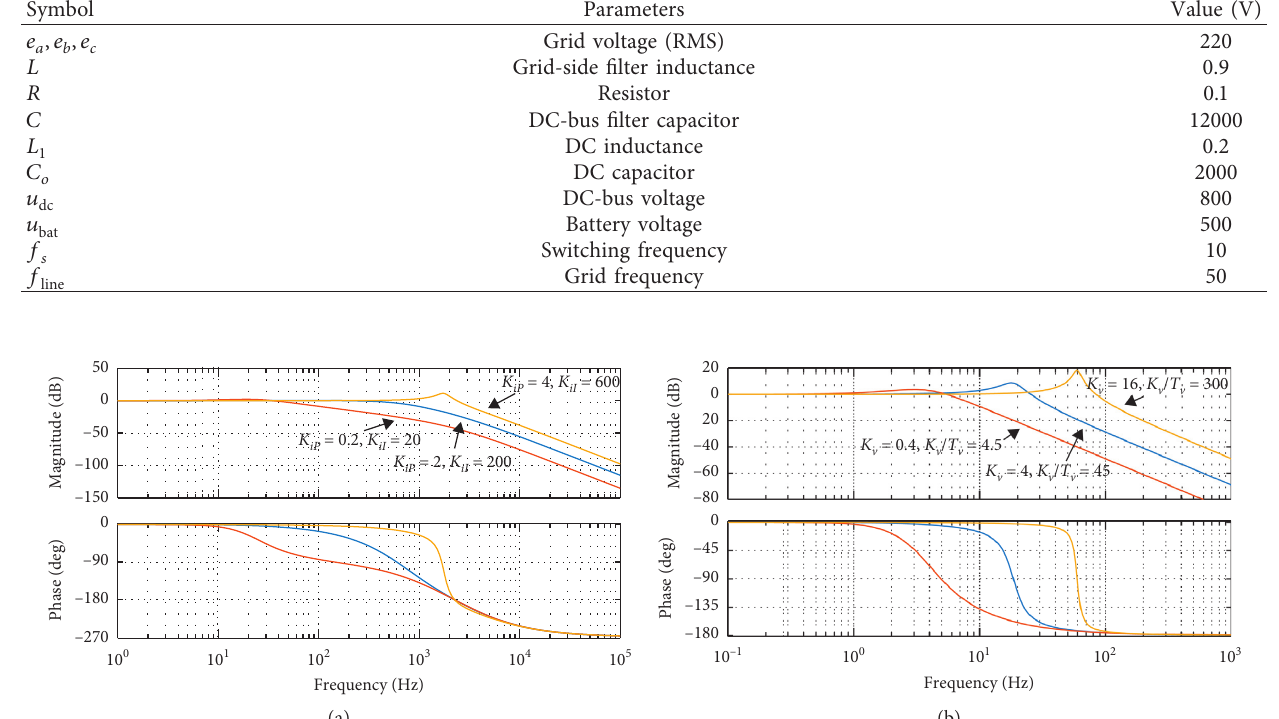
Table 1: System parameters.